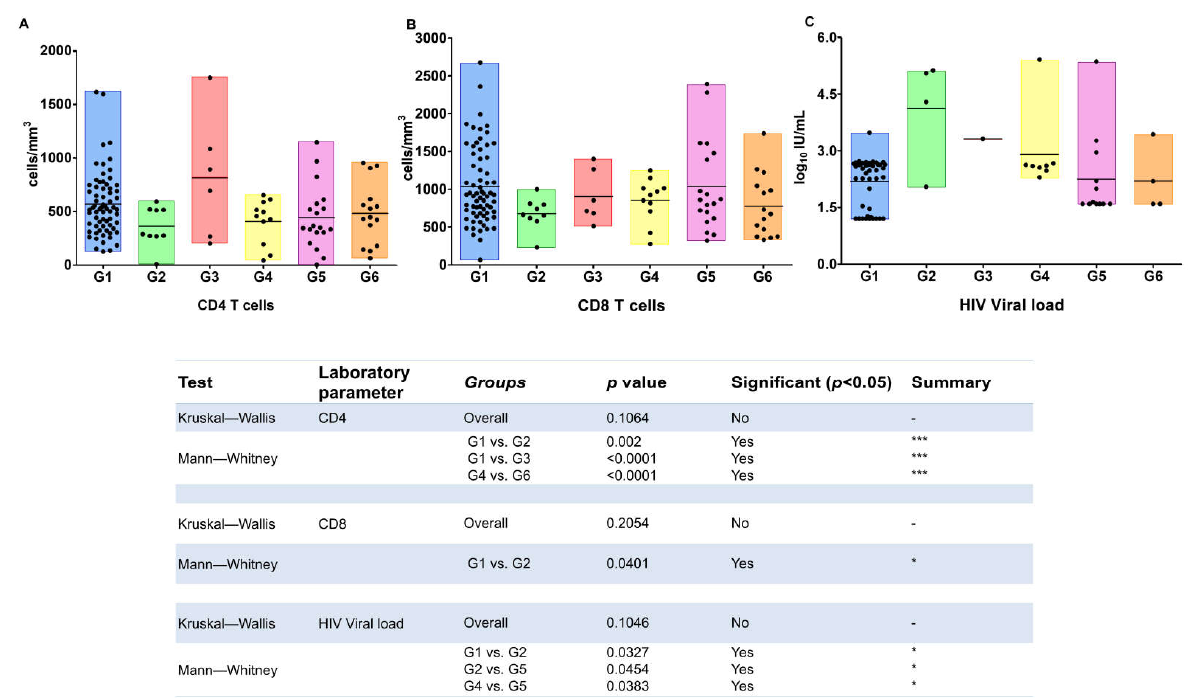
Figure 1. Number of CD4 and CD8 T cells and levels of HIV viral load in patients with HIV infection and HTLV-1, HTLV-2, and/or HCV co-infections. G1 (HIV), G2 (HIV/HTLV-1), G3 (HIV/HTLV-2), G4 (HIV/HCV), G5 (HIV/HCV/HTLV-1), G6 (HIV/HCV/HTLV-2). Subfigures ( A – C )refer to the values of CD4 T cells, CD8 T cells and HIV viral load quantification, respectively. The horizontal line inside the bars denotes mean values. Differences statistically significant are depicted using Kruskal–Wallis analysis of variance for three or more groups and Mann–Whitney U-test for two groups. p -values depicted as asterisks correspond to: * p < 0.05; *** p ≤ 0.001. In relation to cytokines and chemokines present in the plasma samples of such pa- tients’ groups, in general, low levels were detected, and only eight out of fifteen analytes (cytokines and chemokines) evaluated could be compared. The results of the mean value and interquartile range (IQR—1st and 3rd) are presented in Table 2; statistically signifi- cant differences and the major mean values were highlighted. The mean values and the scatter plot of these values in each study group along with the statistical differences among groups are presented in Figures 2 and 3. Table 2. Cytokines and chemokines detected in plasma samples of HIV-infected and HTLV-1-, HTLV-2-, and/or HCV-co-infected patients.